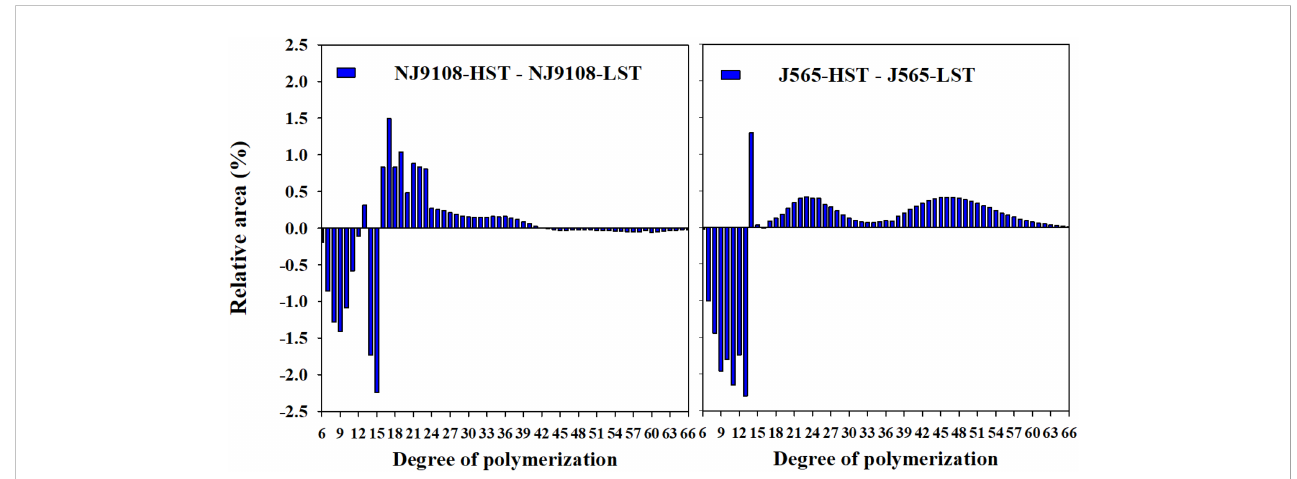
FIGURE 5 Differences in amylopectin chain length distribution between the two growth seasons. HST and LST represent high seasonal temperature and low seasonal temperature, during the reproductive stage in 2017 and 2018. J565 and NJ9108 represent cultivars Jing-565 and